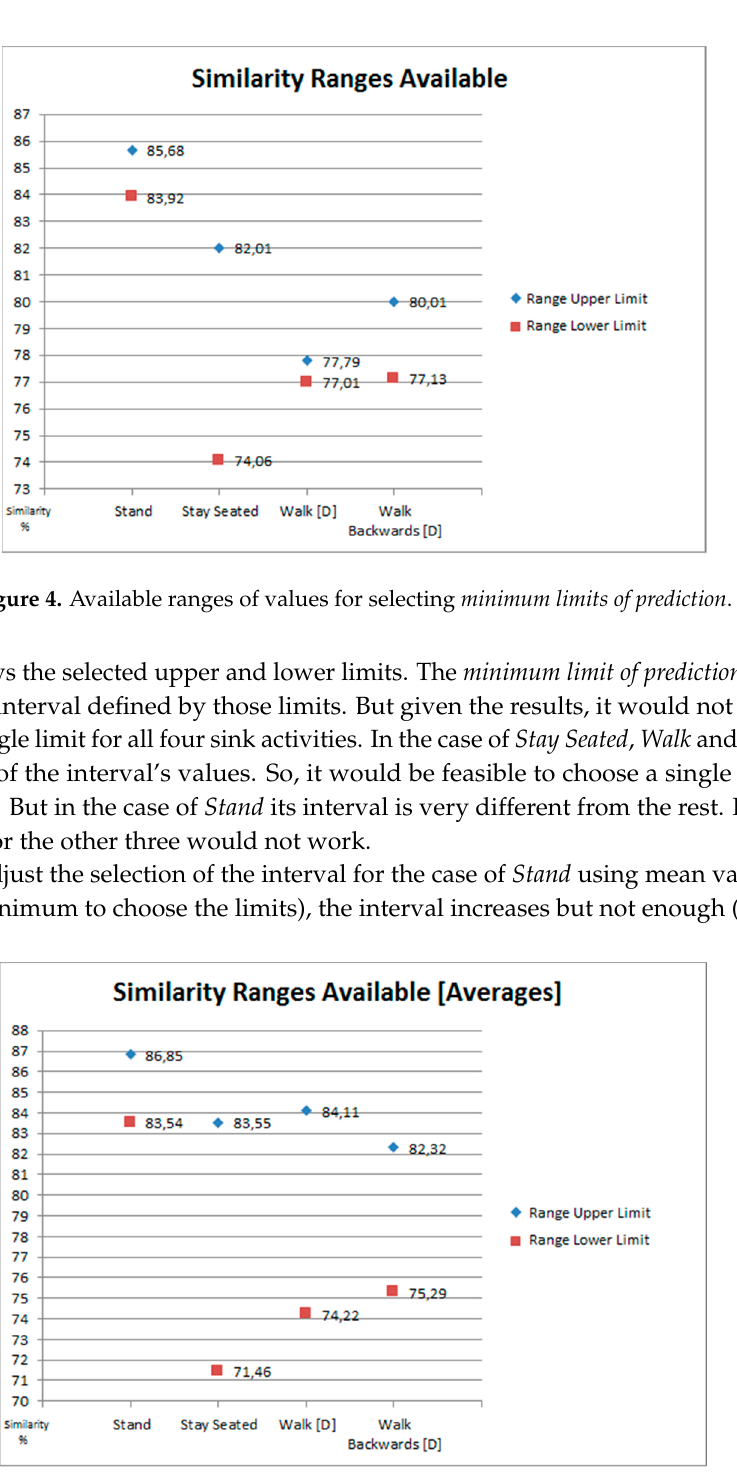
Figure 5. Consequences of widening the range of values of Stand. Table 1. Minimum Limits of Prediction assigned to the Sink Activities.